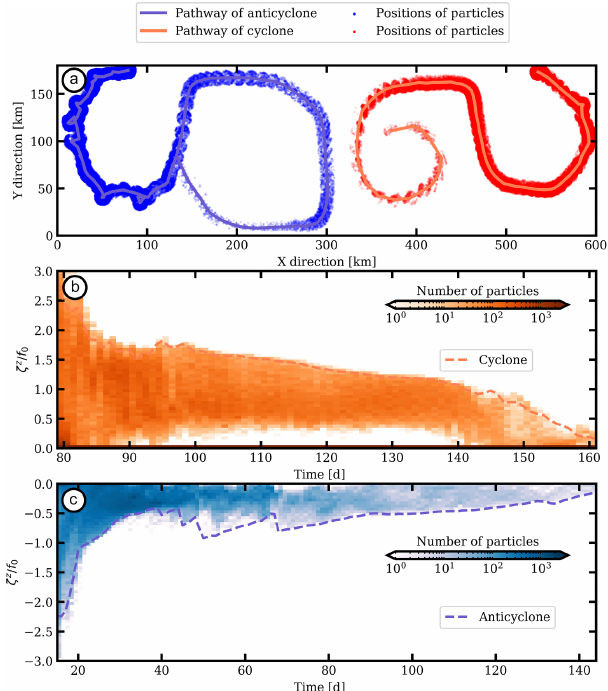
Figure 11. (a) Trajectories of the small vortices considered in Figs. 8 (orange line) and 9 (blue line) and positions of particles located at a distance smaller than 8km from the smaller vortex. (b, c) Time evolution of the histogram of vertical relative vortic- ity normalized by the planetary rotation of particles (colors) and the normalized vertical relative vorticity associated with the small vor- tices (dashed